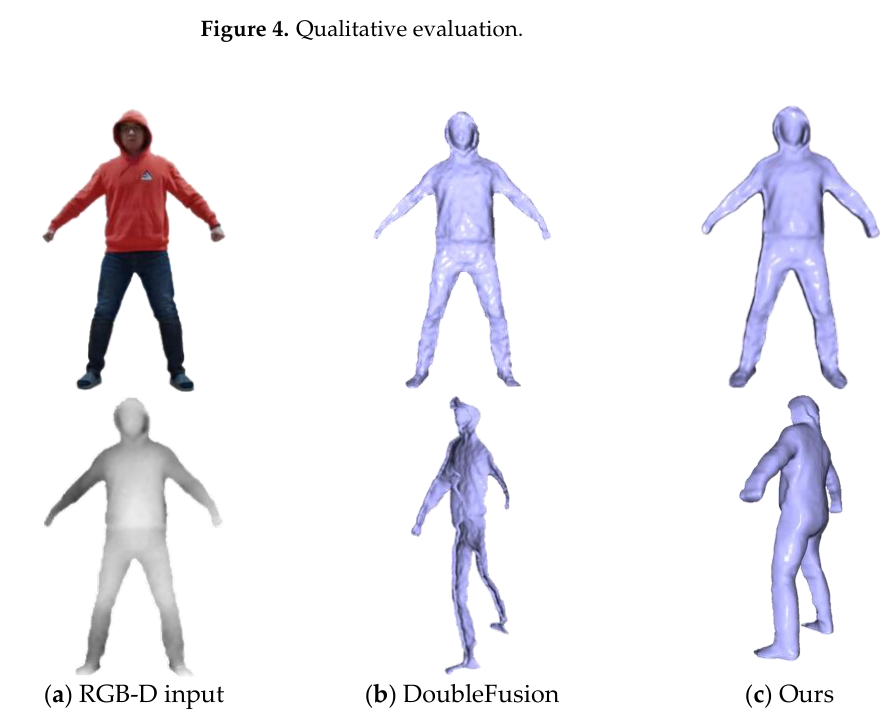
Figure 4. Qualitative evaluation.